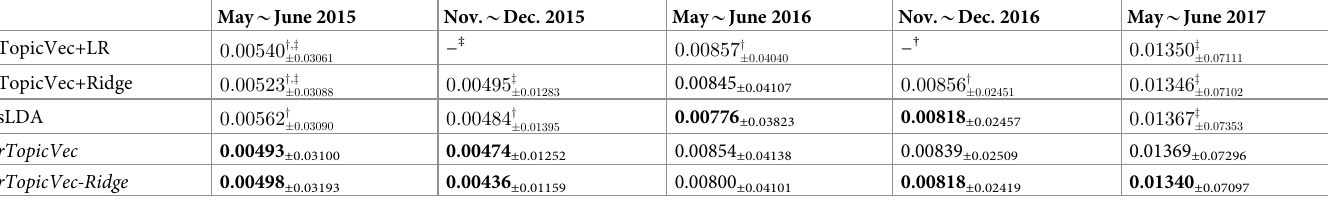
Table 4. MSE and sample standard deviation on the three test sets of stock price prediction when K =